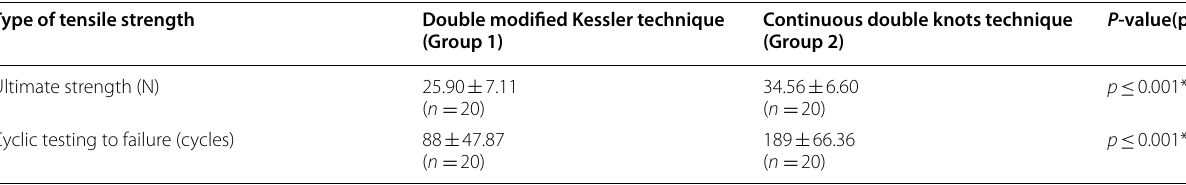
* P -value less than 0.05 for significance (95% confidence intervals in parentheses)